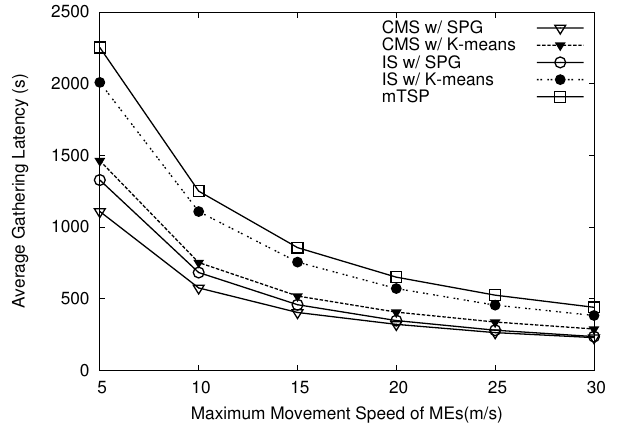
Figure 10. Effects of movement speed on average data-gathering